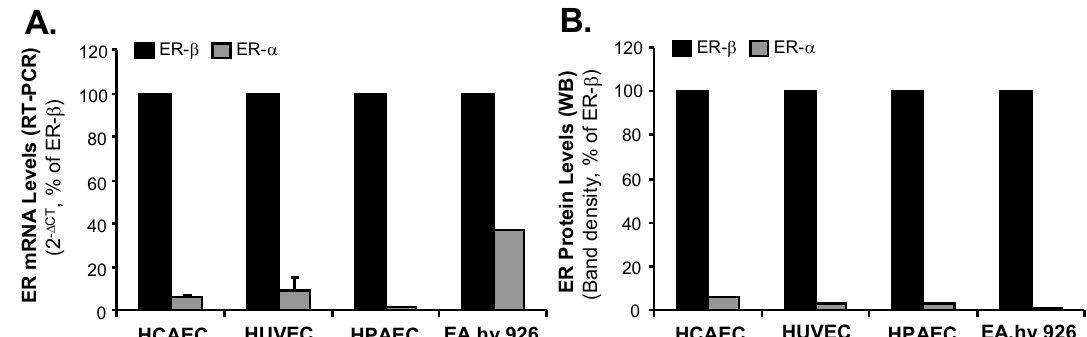
Figure 2. Expression of estrogen receptors (ERs) in human endothelial cells. ( A ) mRNA levels of ER- α and ER- β (Real time PCR). Relative mRNA levels of ER- α and ER- β were calculated as a value of the cycle threshold ( C t ), which was normalized to GAPDH mRNA levels ( C t values) by calculating the 2 [ C t(GAPDH) − C t(ER)] value, simply termed 2 − ∆ C t . For each cell type, mRNA level of ER- β was standardized as 100% (internal control), while the mRNA level of ER- α was compared with that of ER- β ; ( B ) Protein levels of ER- α and ER- β (Western blot). A protein (30 µ g) sample from each cell line was loaded in the each well of SDS-PAGE (10% polyacrylamide) for electrophoresis. ER- β (59 kDa) and ER- α (65 kDa) protein bands were detected by their specific antibodies. The same blot with the same protein loading was used for detecting both ER- β and ER- α proteins. The density of Western blot bands was analyzed by using NIH ImageJ software. Thus, a positive ER-β band could serve as an internal control for ER-α, which had no band. For each cell type, protein level of ER-β was standardized as 100% (internal control), while the protein level of ER-α was compared with that of ER-β. HCAEC (human